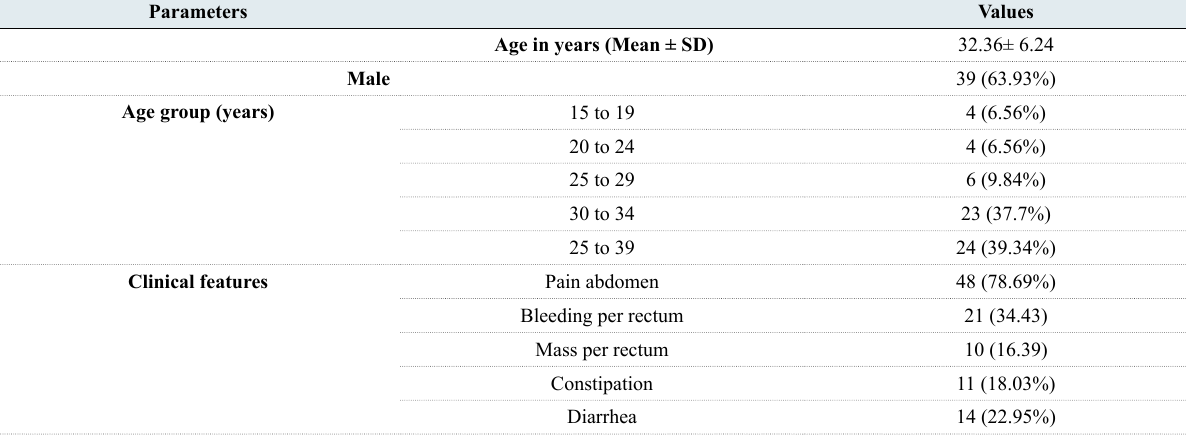
Table 1: Baseline characteristic of the study population